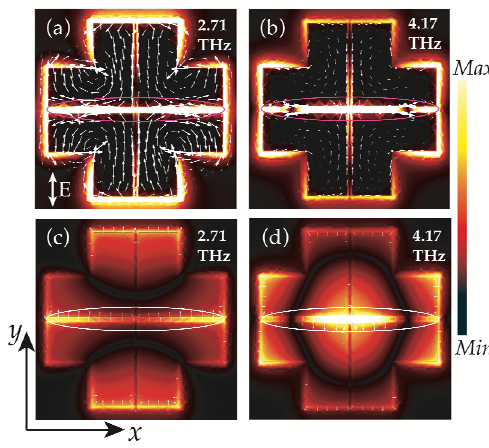
Fig. 4 Distribution of Poynting vectors (white arrows) in (a) and (b) in near surroundings of the structure. In (c) and (d), current density (white arrows) is plotted. The color bar represents the intensity and charge distribution magnitude. Only the TE case is considered.